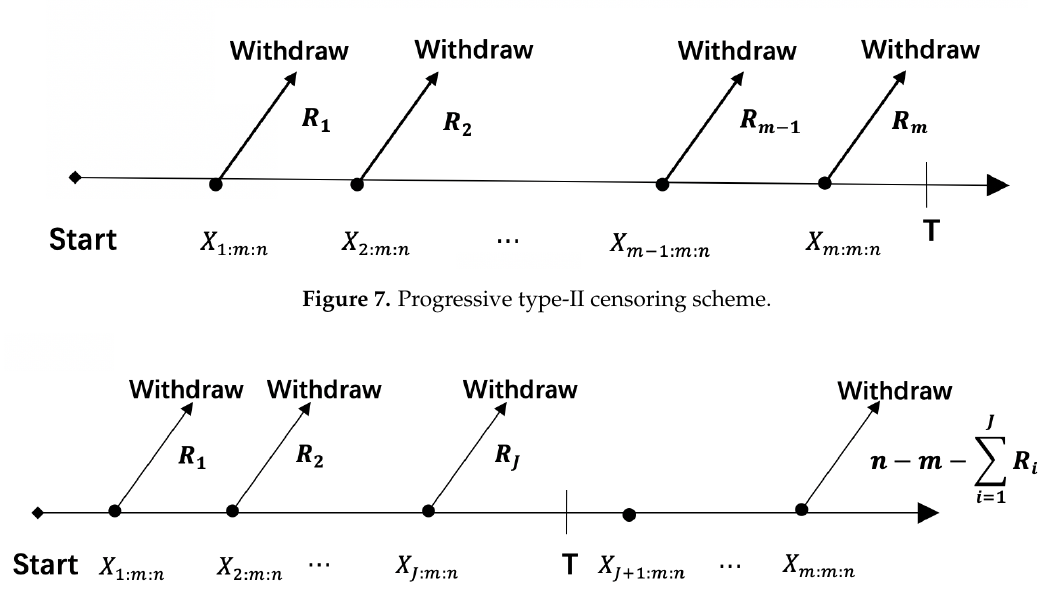
Figure 8. Adaptive progressive type-II censoring